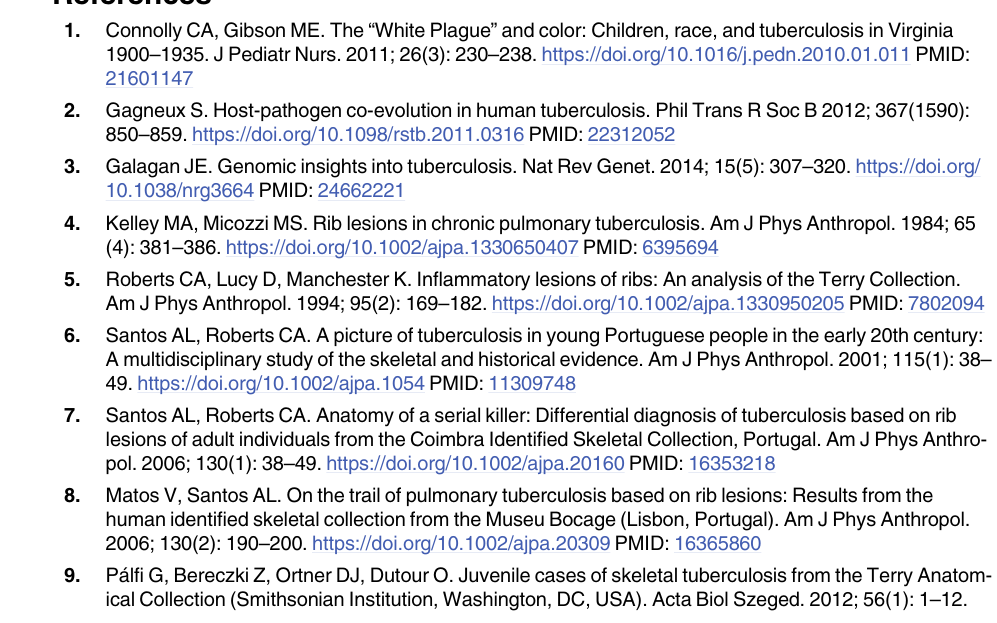
S6 Table. Individual data of cases exhibiting APDIs on the inner skull surface regarding probable TB-related non-endocranial lesions in the NTB group ( S = 62). ( TB = tuberculosis; NTB = non-tuberculous; APDIs = abnormally pronounced digital impres- sions; PNBFs = periosteal new bone formations; HPO = hypertrophic pulmonary osteopathy; + = present;– = not